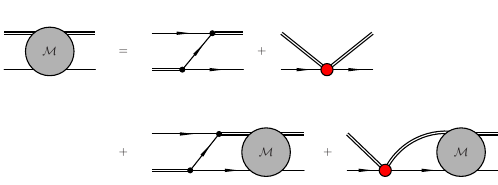
Figure 4: Particle-dimer scattering equation